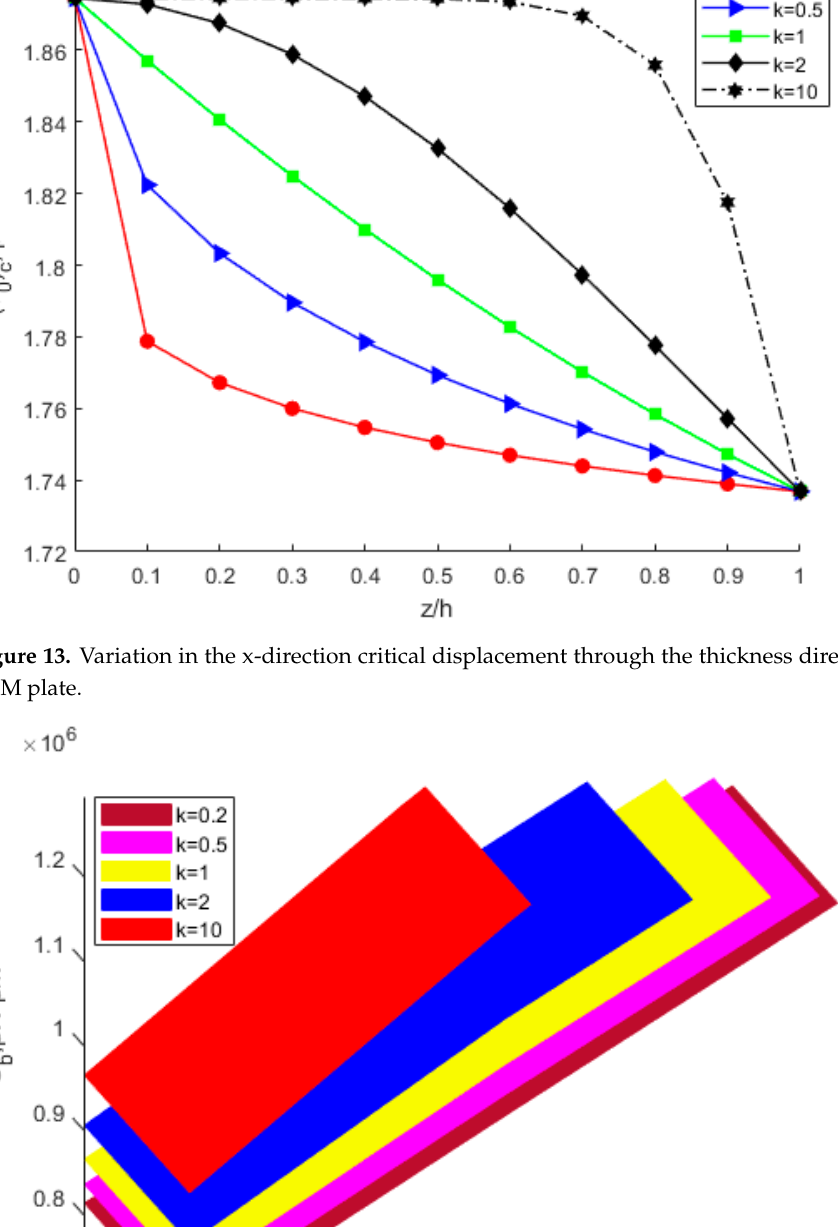
Figure 12. Variation in density through the thickness direction of the FGM plate.